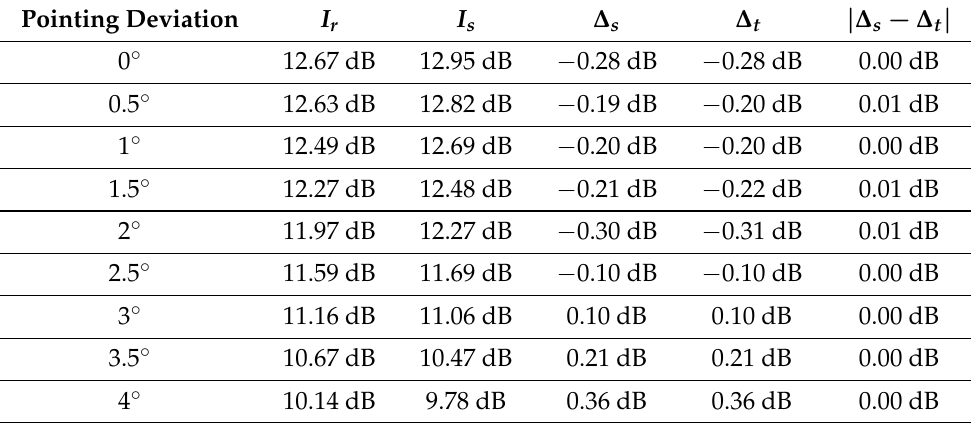
Table 2. The point target energy analysis in the case of alignment